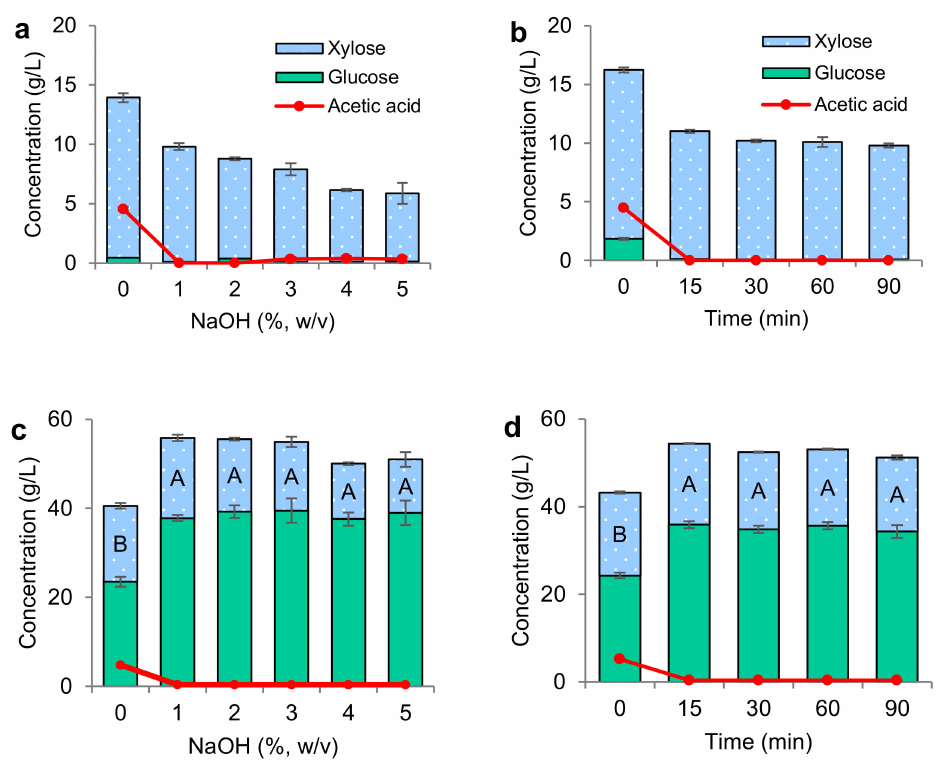
Figure 3. Effect of deacetylation using ( a ) different NaOH loading and ( b ) different reaction times on sugar solubilization and the acetic acid released during dilute oxalic acid pretreatment, and the effect of deacetylation using ( c ) different NaOH loadings and ( d ) different reaction times on the total sugars and acetic acid released during enzymatic hydrolysis. Note: A and B represent the grouping information using the Tukey Method at 95% confidence. Means that do not share the same letter are significantly different; data presented are calculated as means ± standard deviations of the experiments performed in